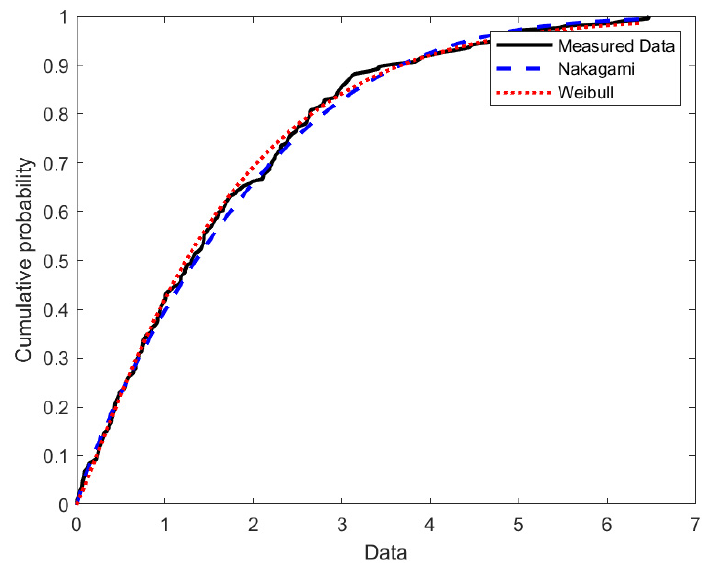
Figure 12. Cumulative distribution functions fitting fast variations within the small lab #1 at 3 GHz, in LoS conditions.